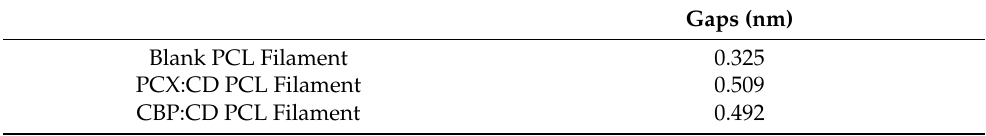
Table 4. PALS analysis results of blank and drug-loaded filaments ( n =